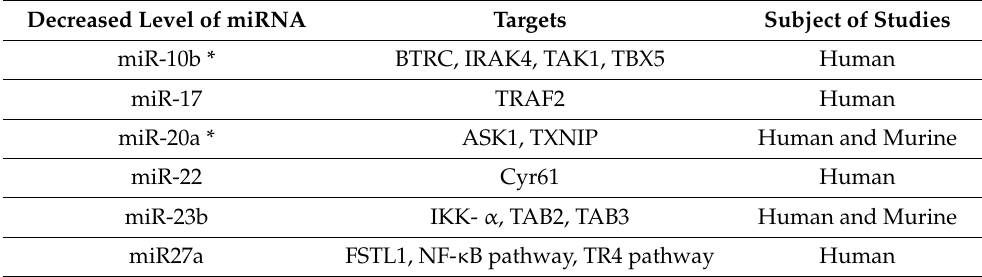
Table 4. List of decreased levels of miRNA in RASFs with their targeted genes [8]. Decreased Level of